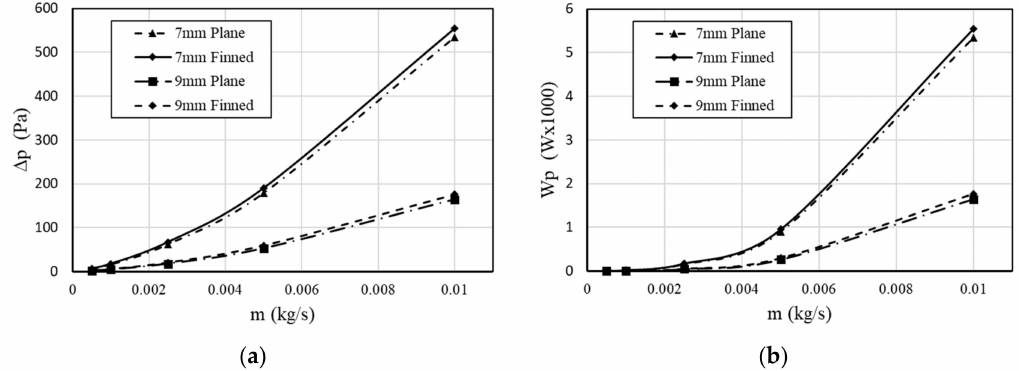
Figure 8. Comparison of the total pressure drop ( ∆ P total ) and pump power ( W p ) in cooling block versus mass flow rate: ( a ) Pressure drop; ( b ) Pump power.